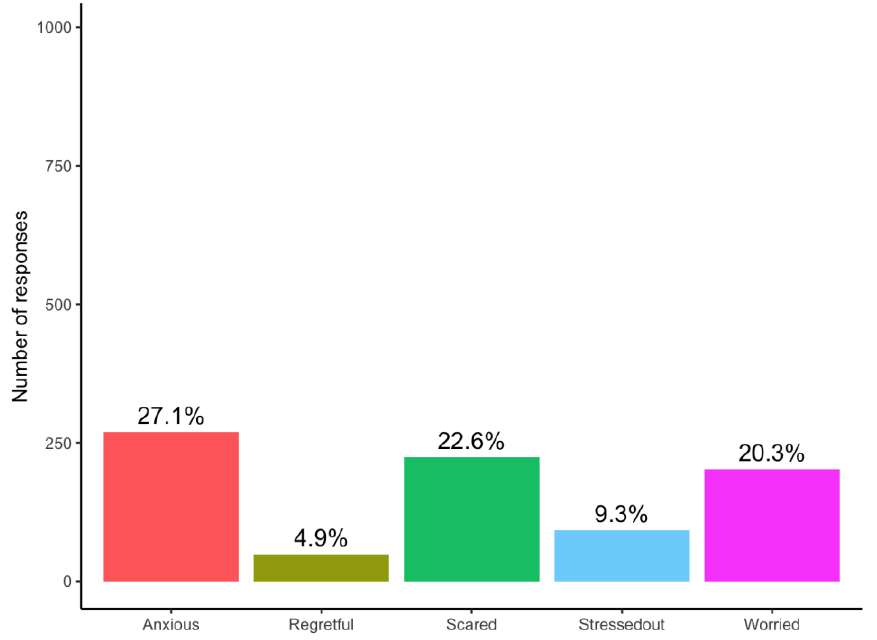
Figure 3. Barplot representing number of responses indicating each positive emotion among 993 participants.